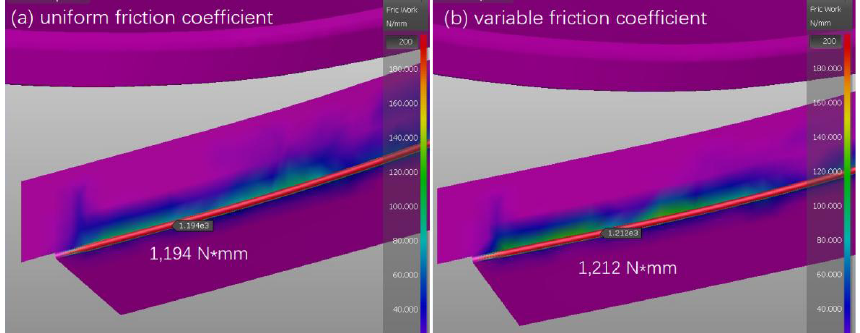
Figure 25. Simulated die wear in terms of friction work: (a) conventional uniform friction coefficient model; (b) enhanced variable friction coefficient